Question: What does this figure show? Answer in one sentence.
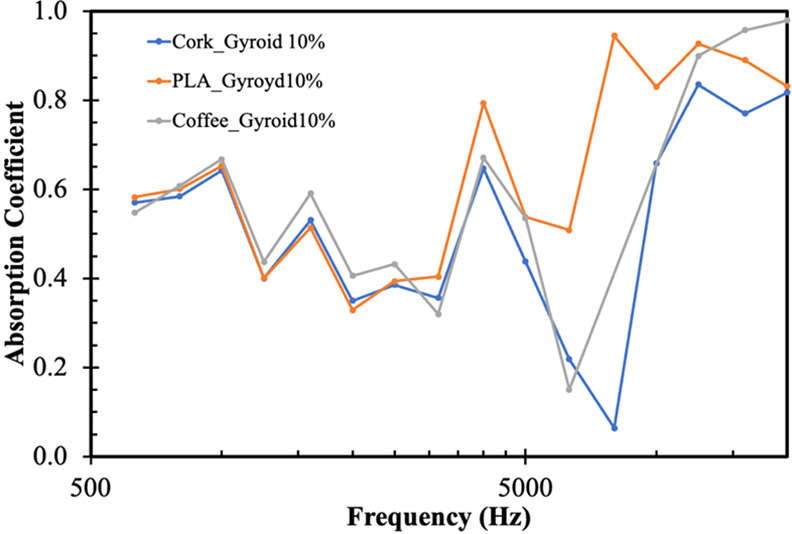
Answer: Sound absorption performance of 3D-printed PLA gyroid composites with biomass fillers (10% infill) as a function of frequency.